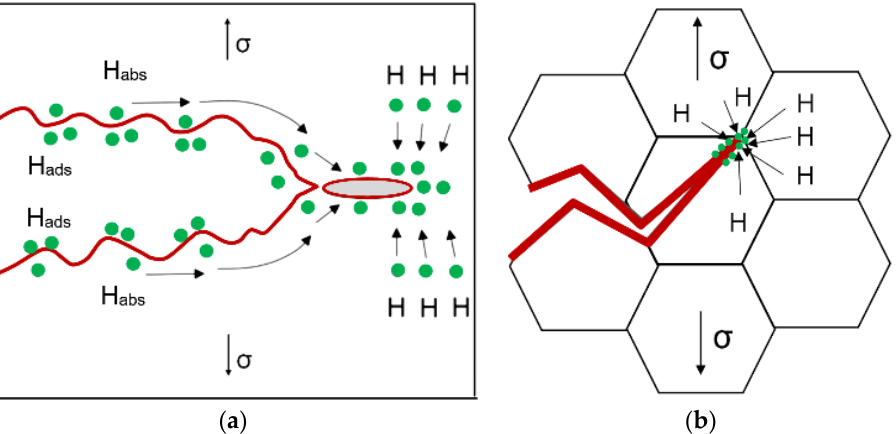
Figure 12. Diagram ( a ) of crack development according to the HEDE theory with hydrogen traps under stress corrosion; diagram ( b ) of the HELP mechanism of crack growth under the influence of diffusible hydrogen and local plastic deformation at the crack tip. Data from